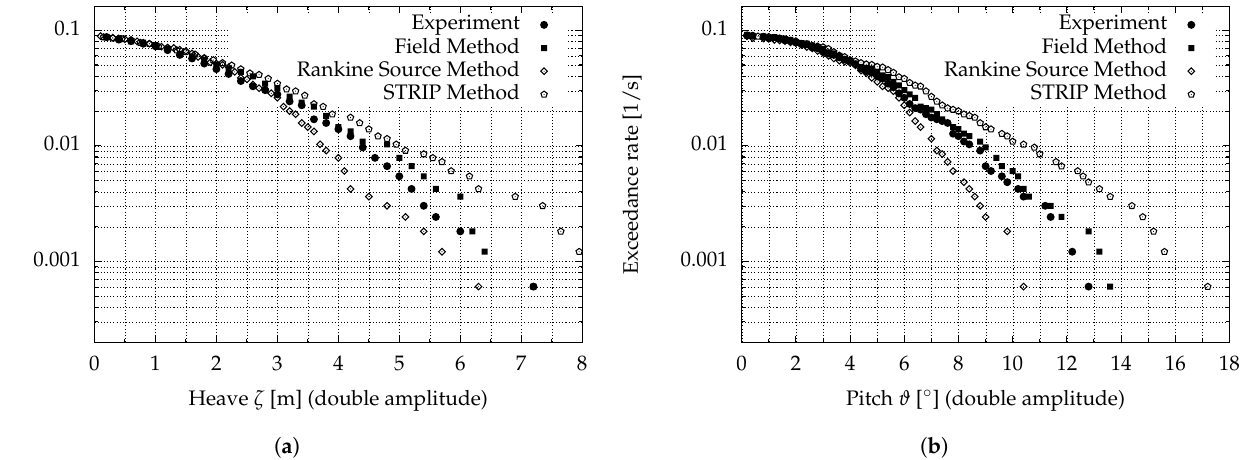
Figure 23. Cruise ship: short-term statistics of ( a ) heave and ( b ) pitch motions.